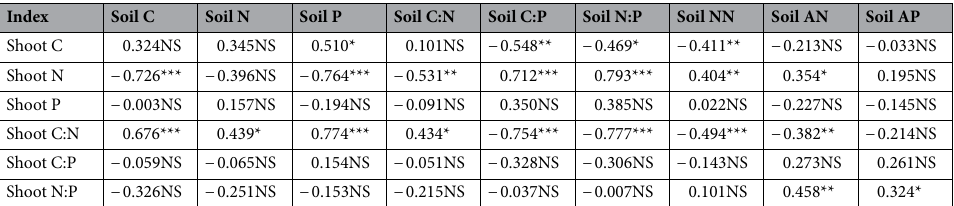
Table 4. Correlation ( R value) between shoot and soil nutrient contents and stoichiometries in alfalfa grassland. The linear regression was analyzed with the model y = ax + b. The linear regression between shoot and soil C, N, P, C:N, C:P, N:P were analyzed with the data in the first cut of 2014 and second cut of 2015 ( n = 24). The linear regression between shoot C, N, P, C:N, C:P, N:P and soil NN, AN, AP contents were analyzed with the data in the first cut of 2014, first and second cuts of 2015 and first cut of 2016 ( n = 48). * P < 0.05; ** P < 0.01; *** P < 0.001. NS no correlation.